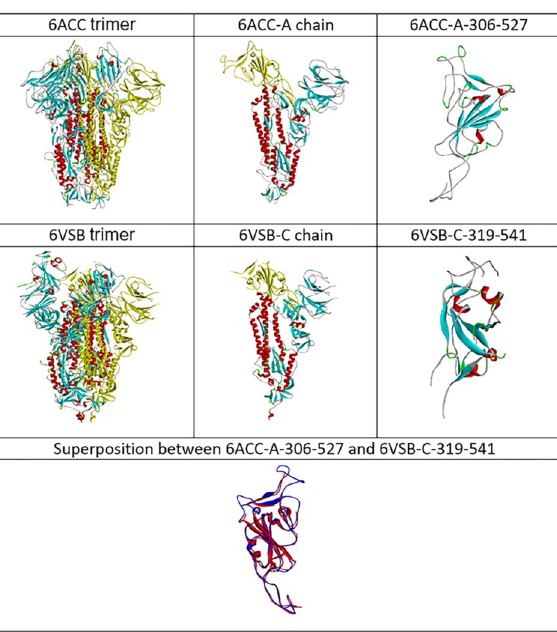
Figure 1. Comparison of 3D structures between 6ACC and 6VSB. The structure of PDB ID 6ACC is the SARS- CoV spike protein, and PDB ID 6VSB is the SARS-CoV-2 spike protein. The trimer of protein 3D structure, chain and domain fragment are displayed. The superposition of fragments between 6ACC-A-306-527 (blue) and 6VSB-C-319-541 (red) are shown at the